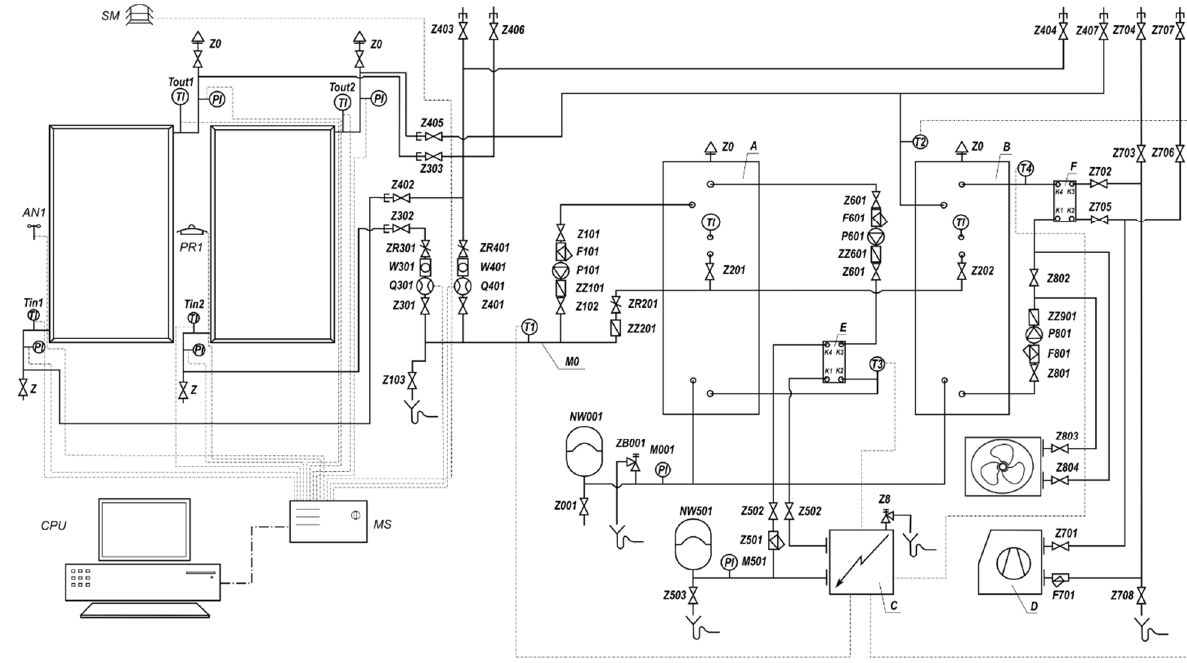
Figure 1. Diagram of the hydraulic system.